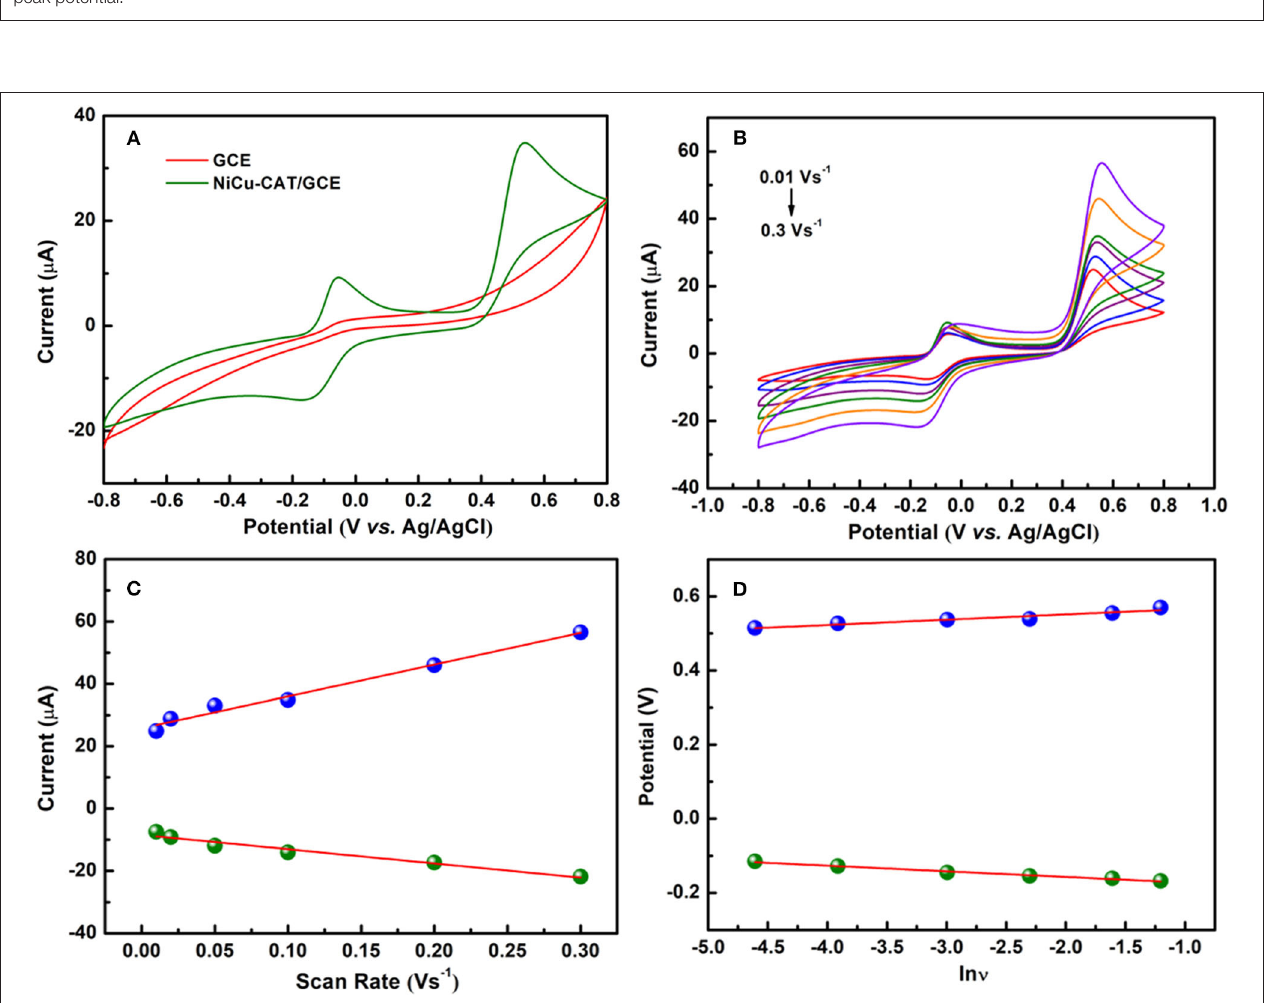
FIGURE 4 | (A) CVs of GCE and NiCu-CAT/GCE in presence of 40 µ M paracetamol. (B) CVs of 40 µ M paracetamol on NiCu-CAT/GCE at scan rates of 10, 20, 50, 100, 200, and 300 mVs − 1 . (C) Displays the plot of the peak current vs. scan rates. (D) Displays the plot of the peak potential vs. ln ν .